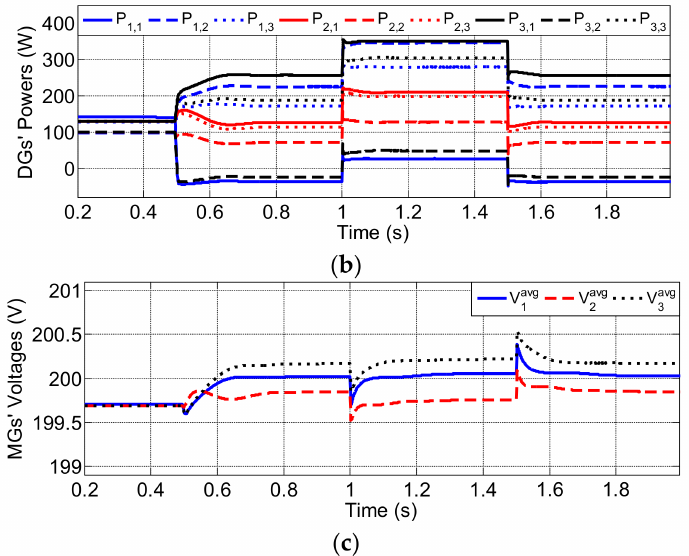
Figure 5. Considering in-equality constraint: ( a ) DGs’ incremental costs, ( b ) MGs’ voltages, and ( c ) DGs’ powers.